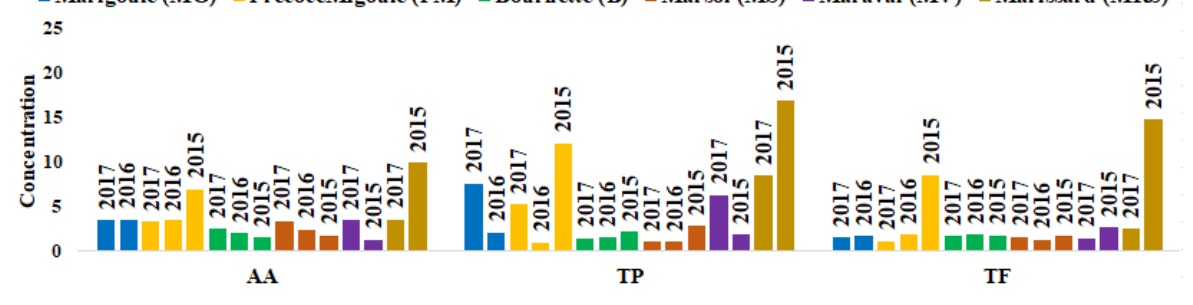
Table 1. Climatic data for R â mnicu V â lcea area during study period (source of data: www.rp5.ru (accessed on 7 February